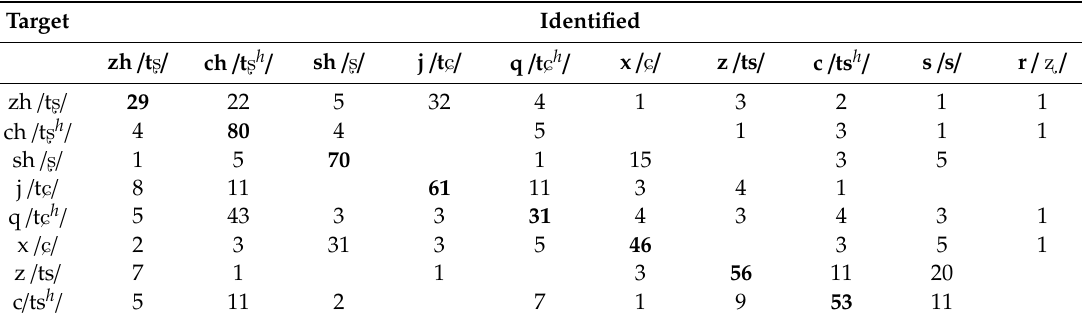
Table 2. Mean percentage correct identification scores (in bold) and confusion matrix of